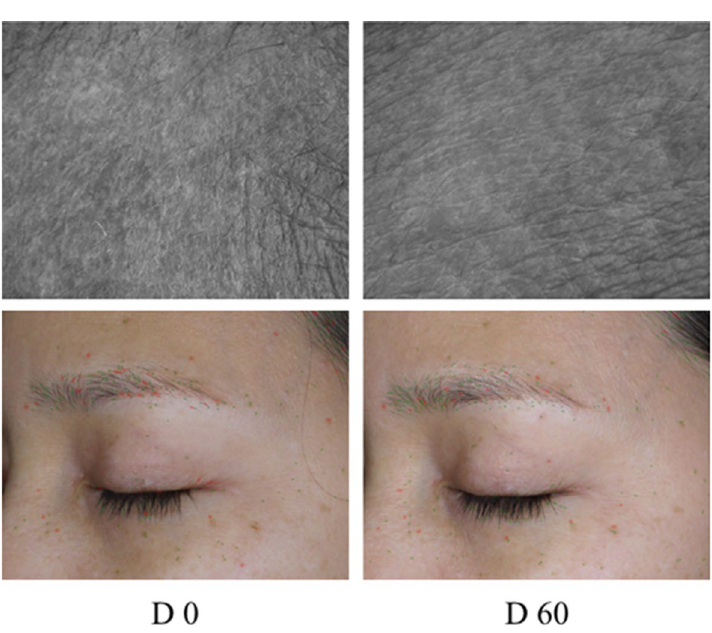
Figure 6. Images of skin wrinkle changes at the corner of the eye of one volunteer in test group after 60 d of